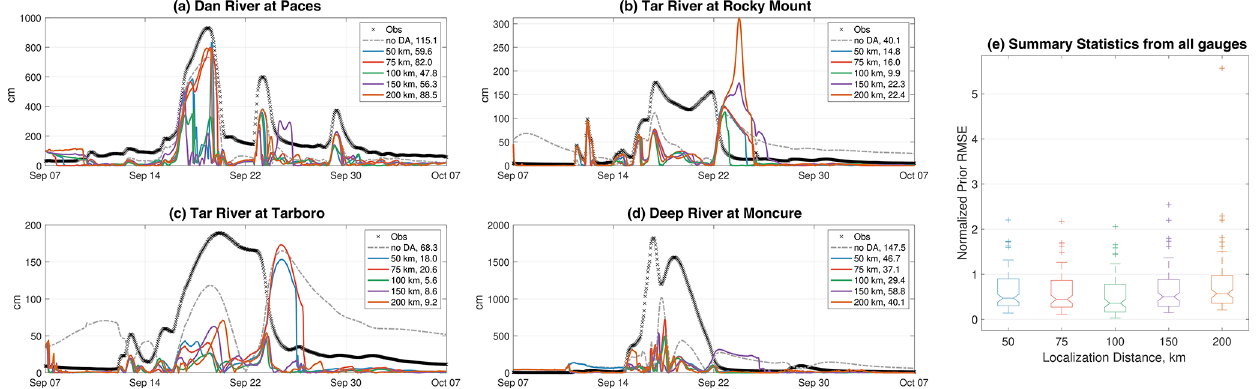
Figure 5. (a–d) Time series of hourly forecast root mean square errors (RMSEs) of five DA experiments using ATS localization with the Gaspari–Cohn function and radius r = 50, 75, 00, 150, and 200km. For each gauge, the observations are plotted by black crosses. The other curves show the RMSE of each run. For example, the open-loop (ensemble run with no DA) RMSE is given by the dashed gray curve. The time-averaged RMSE for each run is reported in the legend. (e) Box plots of the normalized prior RMSEs (time-averaged RMSE divided by the temporal mean of the actual observations at all the gauges), using all gauges as a function of the localization radius.